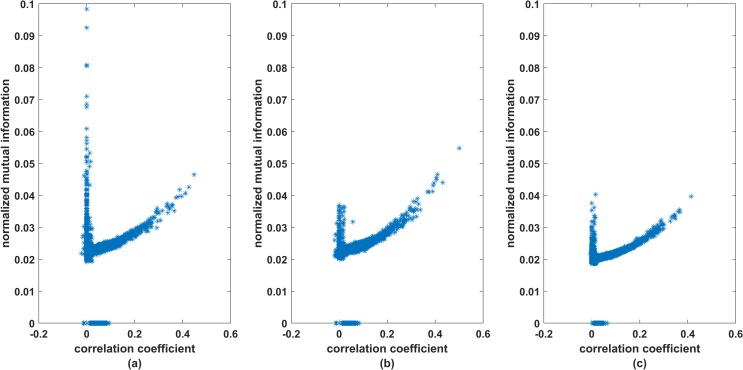
Correlation coefficient versus mutual information: high frequency data.On x-axis we have correlation coefficients and on y-axis we have normalized mutual information for all 3916 pairs. (a), (b) and (c) correspond to pre-election, election and post-election periods.